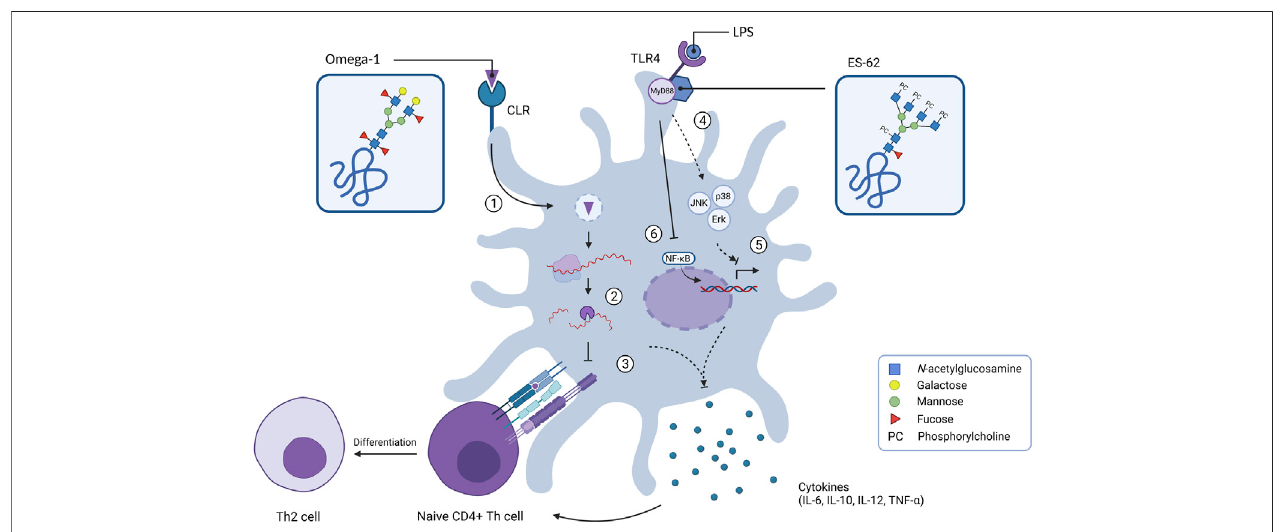
FIGURE2| Internalsignallingofdendriticcellsuponexposureofglycoproteinsomega-1andES-62.C-typelectinreceptorscanbindvariousglycanmotifssuchas LeX on omega-1, which results in uptake of the extracellular antigen. After internalisation in endosomes (1), omega-1 translocates to the cytosol where it interferes with protein translation by exhibiting RNase activity on messenger RNA and ribosomal RNA (2). This suppresses DC maturation by inhibiting IL-12 cytokine release whilst enhancing IL-10 production and down-regulation of co-stimulatory molecules such as CD86. This ultimately results in T helper 2 (Th2) cell polarisation (3). Glycoprotein ES-62 biases the immune system towards an anti-in fl ammatory/Th2 response as it is able to mediate the LPS-induced TLR4 signalling by regulating the activity of kinases Erk, JNK and p38 via adaptor molecule MyD88 (4). This leads to down-regulation of gene transcription of Th1-associated cytokines (IL-6, IL-12p38 subunit and TNF- α ) (5). ES-62 inhibits the production of IL-12p40 subunit by preventing the binding of transcription factor NF- κ B to the IL-12 promotor